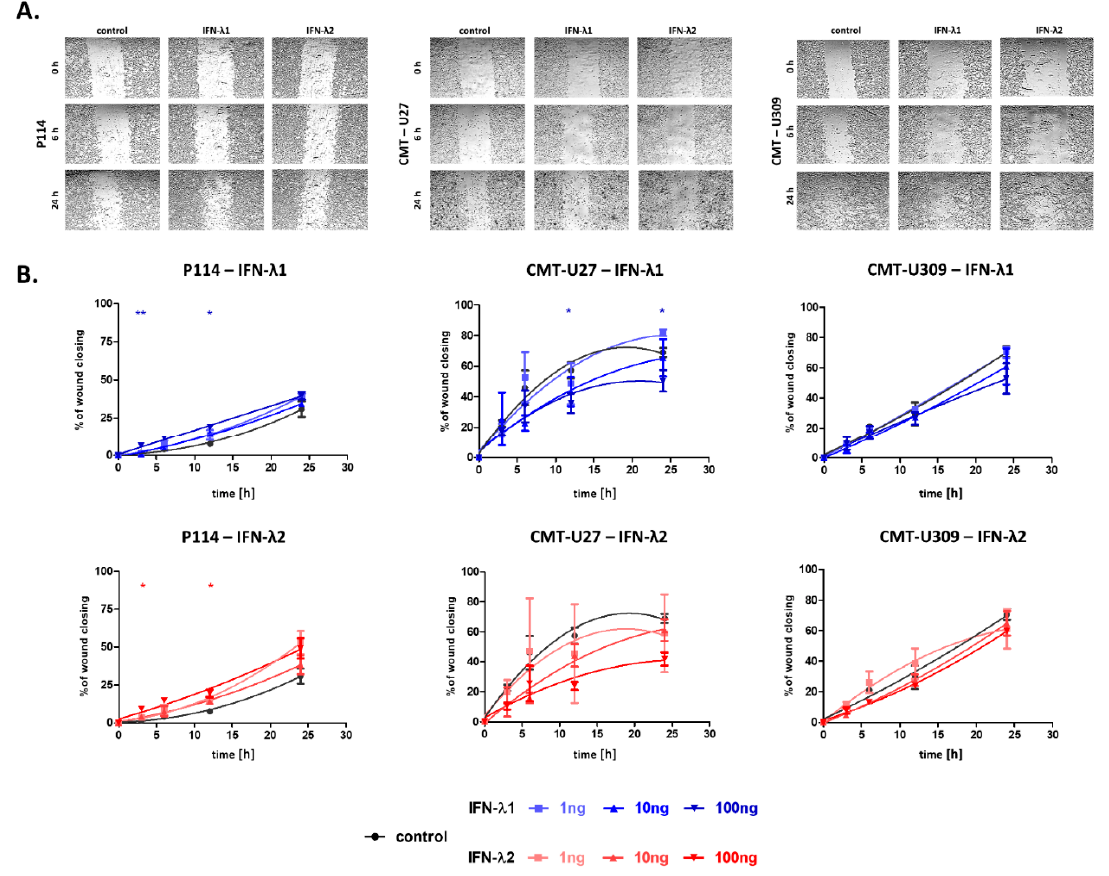
Figure 3. Pictures of the wound-healing processes of CMT cells under IFN- λ 1 or IFN- λ 2 treatment at the concentration of 100 ng/mL at the selected time points after scratching ( A ) The graphs showing the wound healing speed in time after scratching in cells cultured in control conditions or treated with IFN- λ 1 or IFN- λ 2 ( B ). The results are presented as the mean ± SEM. A one-way ANOVA and Dunnet’s HSD post hoc test were applied. The statistical differences found between control cells and cells treated with IFN- λ at 100 ng/mL concentration are presented by asterisks. Significance levels are indicated as follows: * p < 0.05; ** p < 0.01.